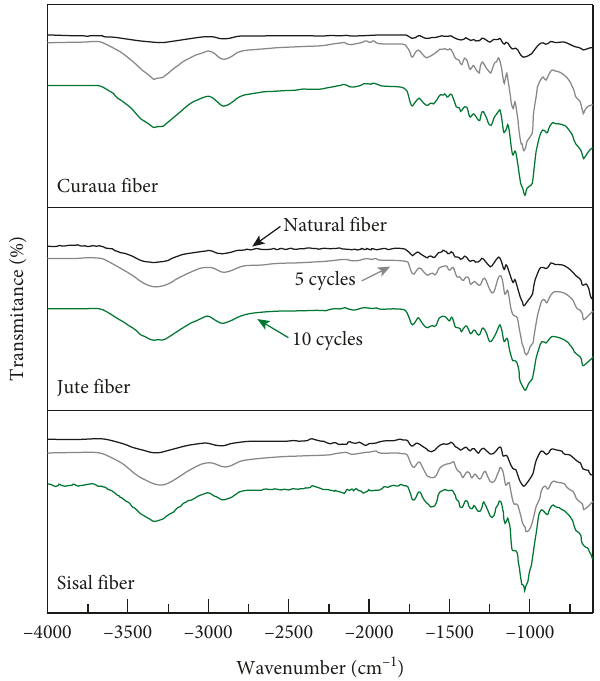
Figure 7: FTIR spectra of natural fibers, and fibers after 5 and 10 cycles of wetting and drying cycles [44]. Reproduced with per- mission from